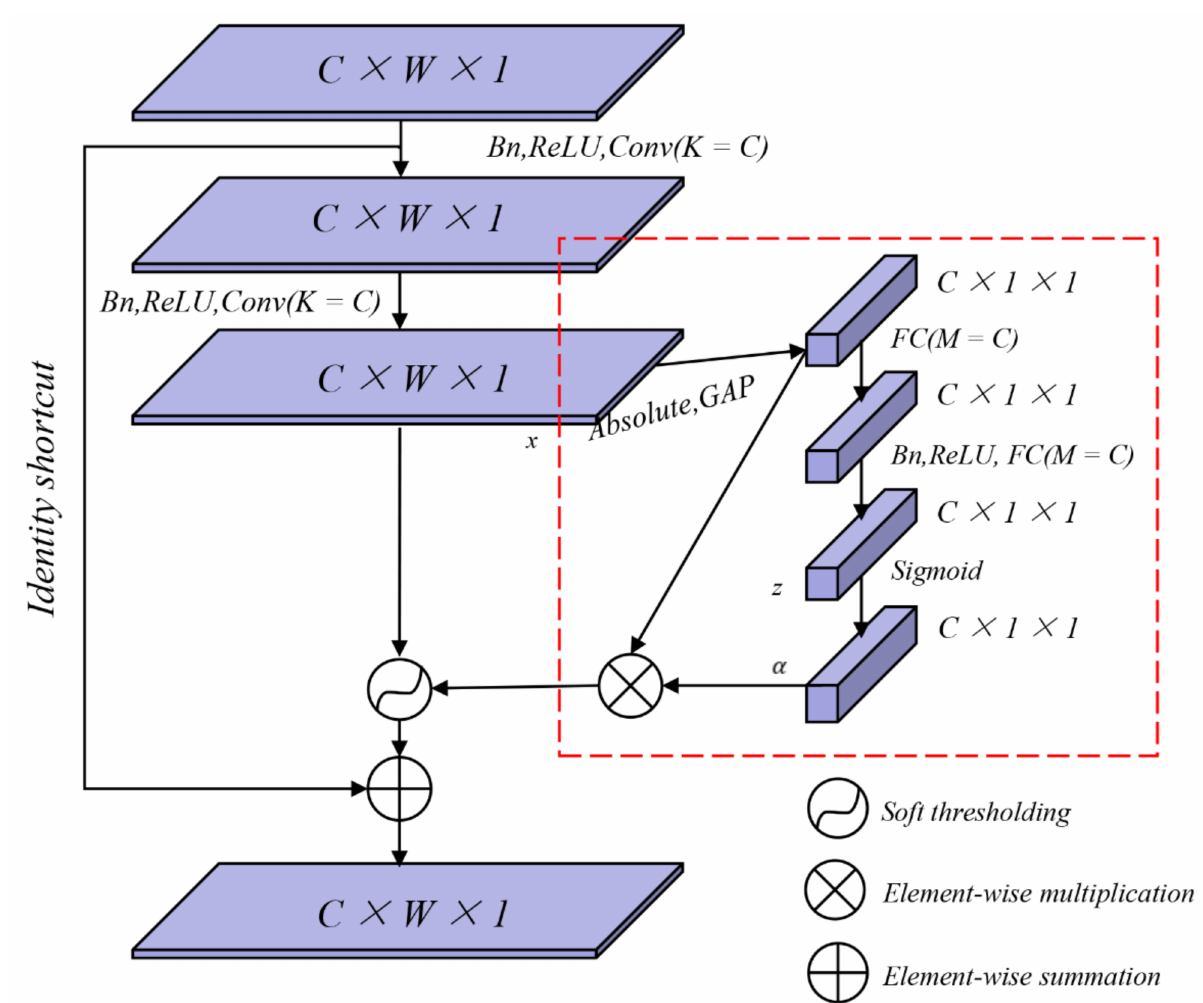
Figure 3. Residual shrinkage building